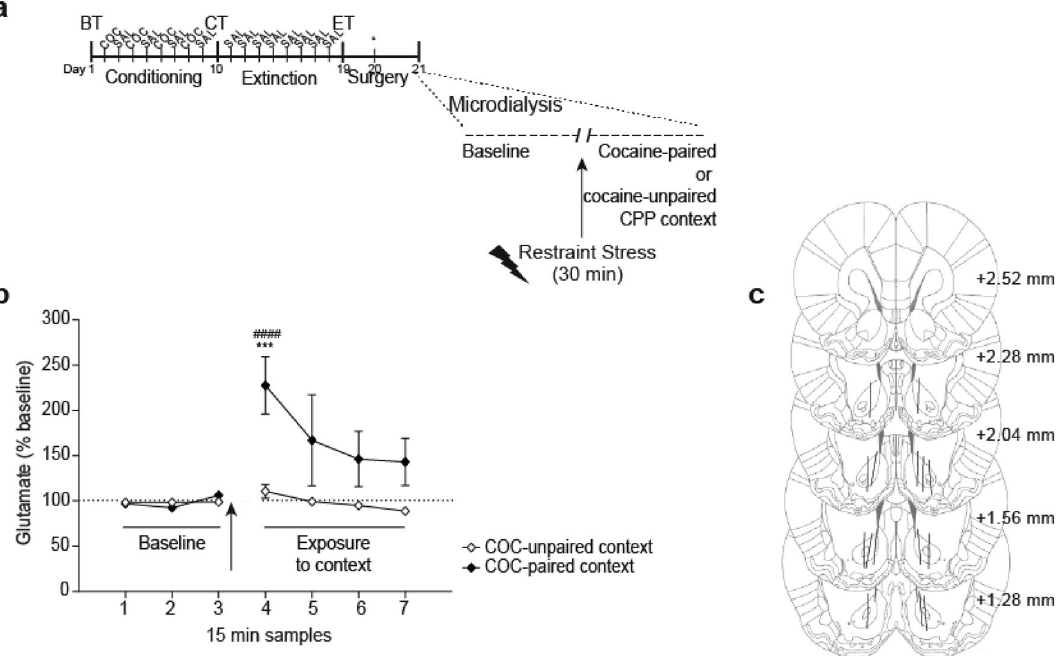
Figure 6. Restraint stress caused an enhancement of extracellular glutamate in NAcore that depended on the CPP context. ( a ) Timeline of CPP procedure. After confirming extinction of the cocaine-CPP behavior (data not shown, no differences in preferences scores between groups, Student’s t test, cocaine-paired vs unpaired context: t = 1.08, p = 0.297), animals were submitted to probe implantation the day before collecting samples. In vivo microdialysis was performed to sample (every 15 min) extracellular glutamate in NAcore both before (baseline, in home cage) and after transfer of animals to either compartment of the CPP apparatus. After 120 min of collecting basal samples inside the home cage, animals were submitted to restraint stress for 30 min and then re-exposure to the previous cocaine-paired or -unpaired context. Glutamate was quantified using EZChrom Elite software, version 4.0 (http:// www. agile nt. com). ( b ) A significant increase of glutamate in NAcore was observed when animals were re-exposed to the cocaine-paired, but not the cocaine-unpaired context, after being exposed to restraint stress (***p < 0.001 compared with cocaine-unpaired context group at the same time point; #### p < 0.0001 compared with the last baseline sample, Bonferroni’s multiple comparisons post-hoc test). Values represent percentage of increase in glutamate release from baseline (mean ± s.e.m.) for each 15 min sample, n = 7–8 for each group. Arrow indicates the restraint stress exposure. ( c ) Unilateral locations of microdialysis membranes (solid lines) in NAcore for subjects that were included in the present analysis. Numbers to the right indicate millimeters from the